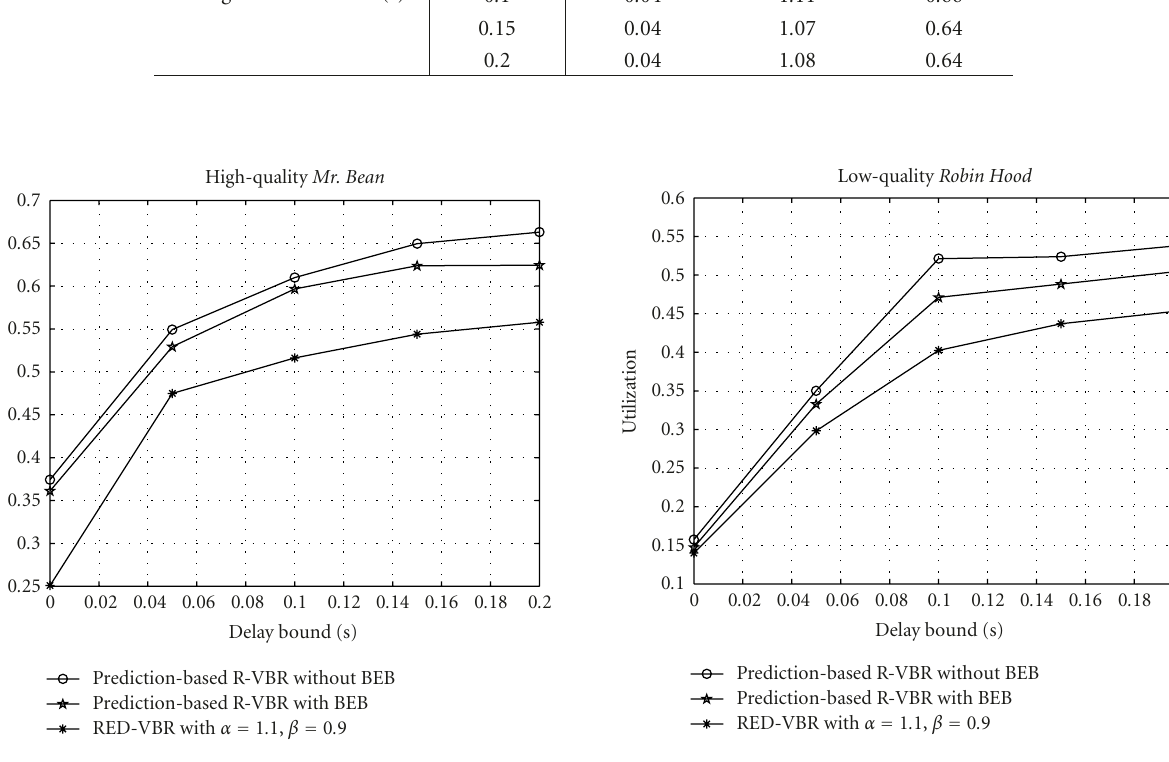
Figure 6: E ff ect of the BEB-based renegotiation control algorithm for Robin Hood . (The performance of RED-VBR is also plotted to illustrate the minimal impact of the link utilization with BEB-based